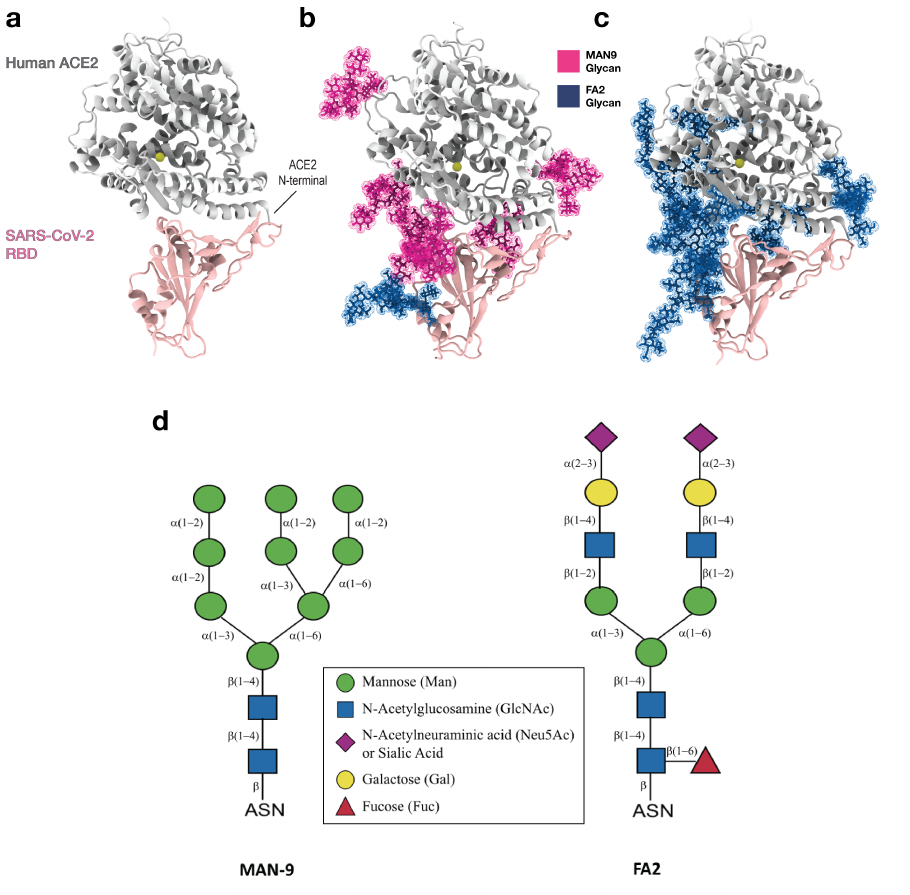
Figure 1. Simulations of the RBD-ACE2 complex in the absence and presence of different glycan types. ( a ) Structural representation of human receptor ACE2 (silver) bound to RBD of SARS-CoV-2 (pink). The yellow bead in ACE2 depicts the zinc ion that is coordinated by His374, His378, Glu402, and one water molecule. ( b ) Same protein complex as in panel ( a ) except that six MAN9 glycans (magenta) are bound to ACE2 (at Asn53, Asn90, Asn103, Asn322, Asn432, Asn546) and one FA2 glycan (blue) is bound to RBD (at Asn343). ( c ) Same complex as in ( b ) except that the six ACE2 glycans are FA2. Panels ( a – c ) represent three systems for which separate sets of simulations were performed. All molecular graphics were created using VMD [15]. ( d ) Schematic representation of N-glycans. Oligomannose (MAN9) and complex (FA2) glycans are depicted using the Symbol Nomenclature for Glycans